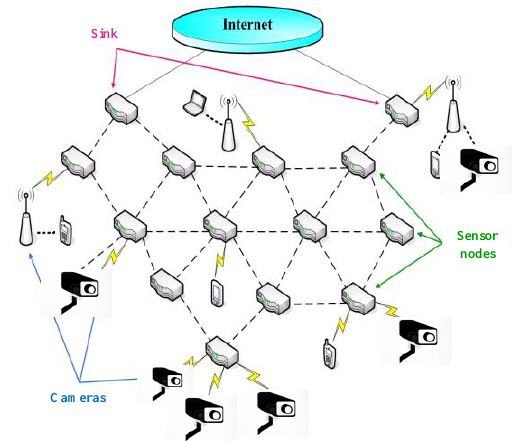
Figure 1. Wireless Visual Sensor